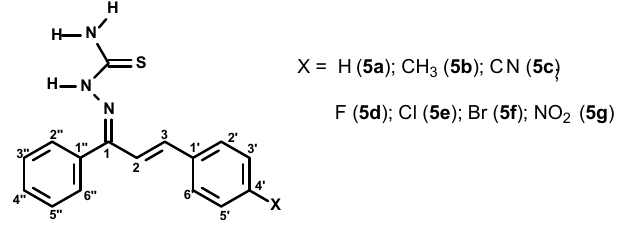
Figure 3. Chemical structure for the synthetic chalcones 3a – g .